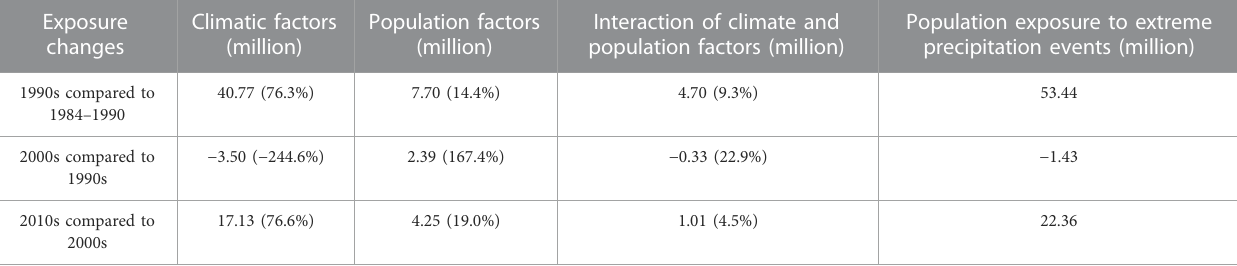
TABLE 1 Analysis of factors in fl uencing change in population exposure to extreme precipitation events across the Poyang Lake Basin. Exposure changes